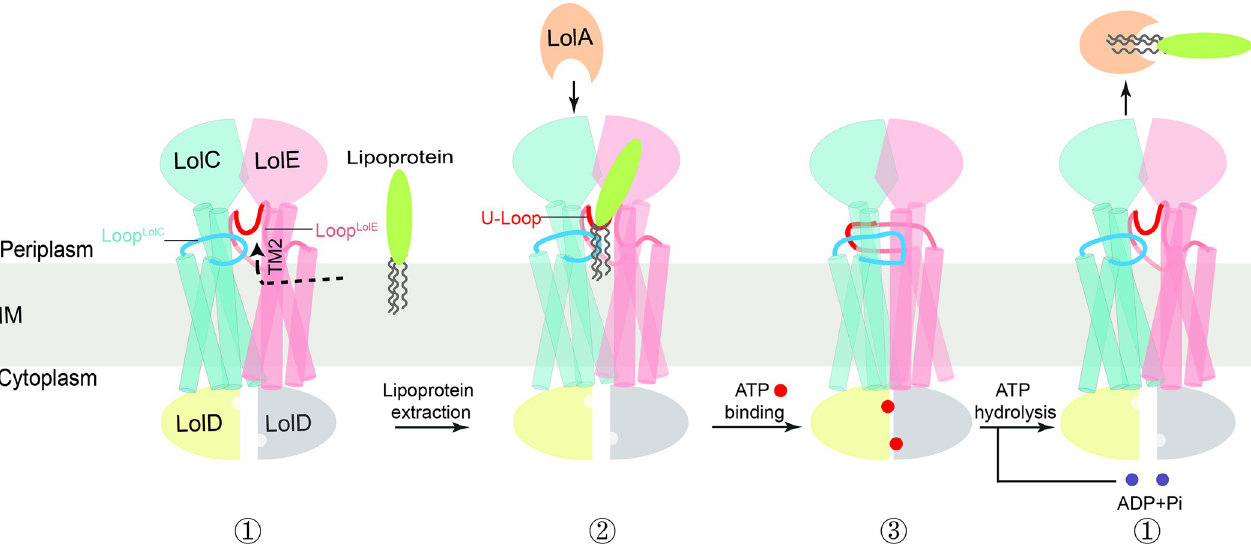
Fig 7. Proposed model for lipoprotein extraction and transfer to LolA. ATP and ADP are shown as balls in red and purple, respectively. The dashed arrow indicates the path for lipoproteins entry into the cavity. Our apo-LolCDE, RcsF-LolCDE and AMPPNP-LolCDE structures represent structures in ①, ②, and ③ ,